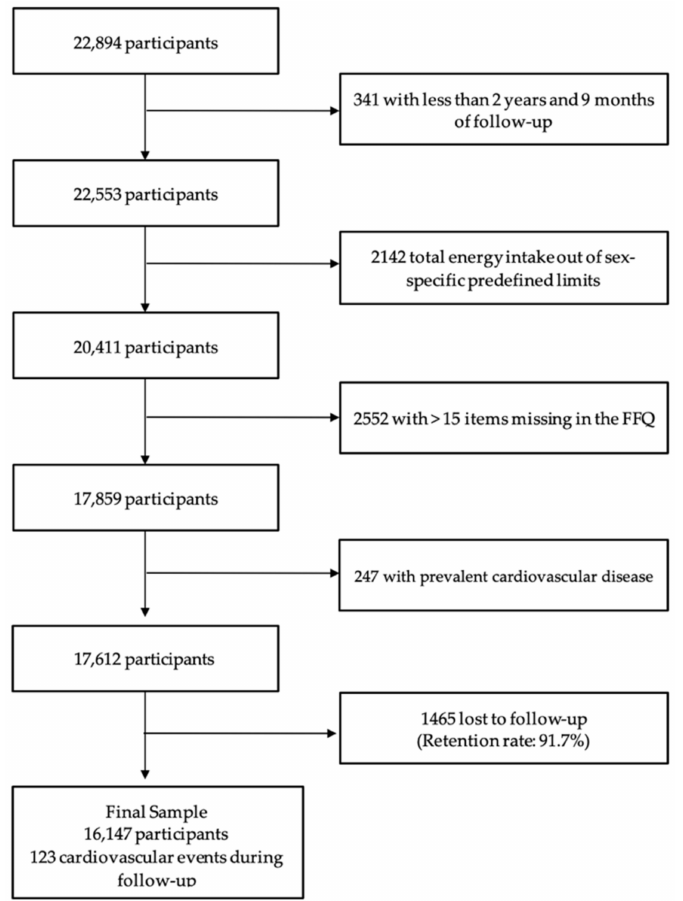
Figure 1. Flowchart of participants in the SUN (‘Seguimiento Universidad de Navarra’) included in analyses of (poly)phenol intake and incident cardiovascular diseases. Abbreviation: Food frequency questionnaire